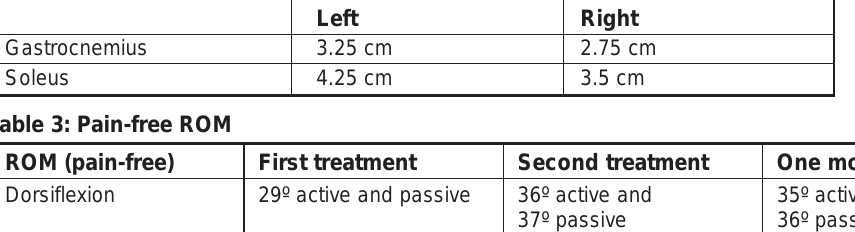
Table 2: Calf muscle length (distance from heel to ground off 10cm step)